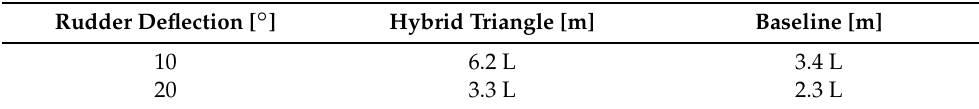
Table 9. Turning circle maneuver: steady turning diameter for the most and least stable models through implementation of